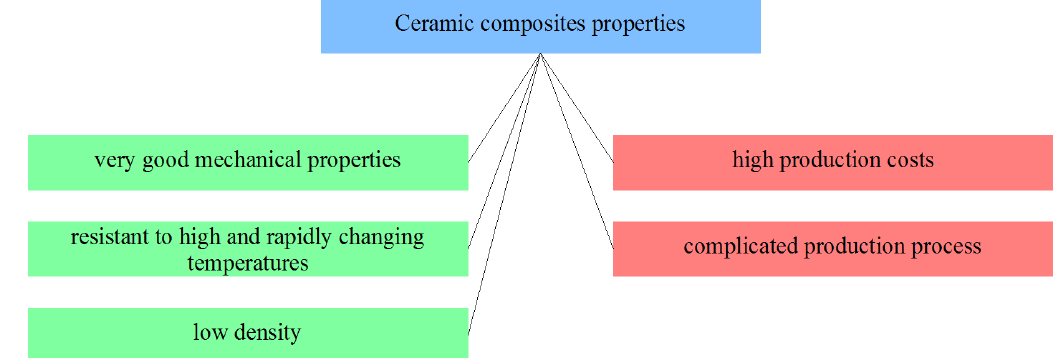
Figure 17: Selected ceramic composites properties from the point of view of applicability in friction materials